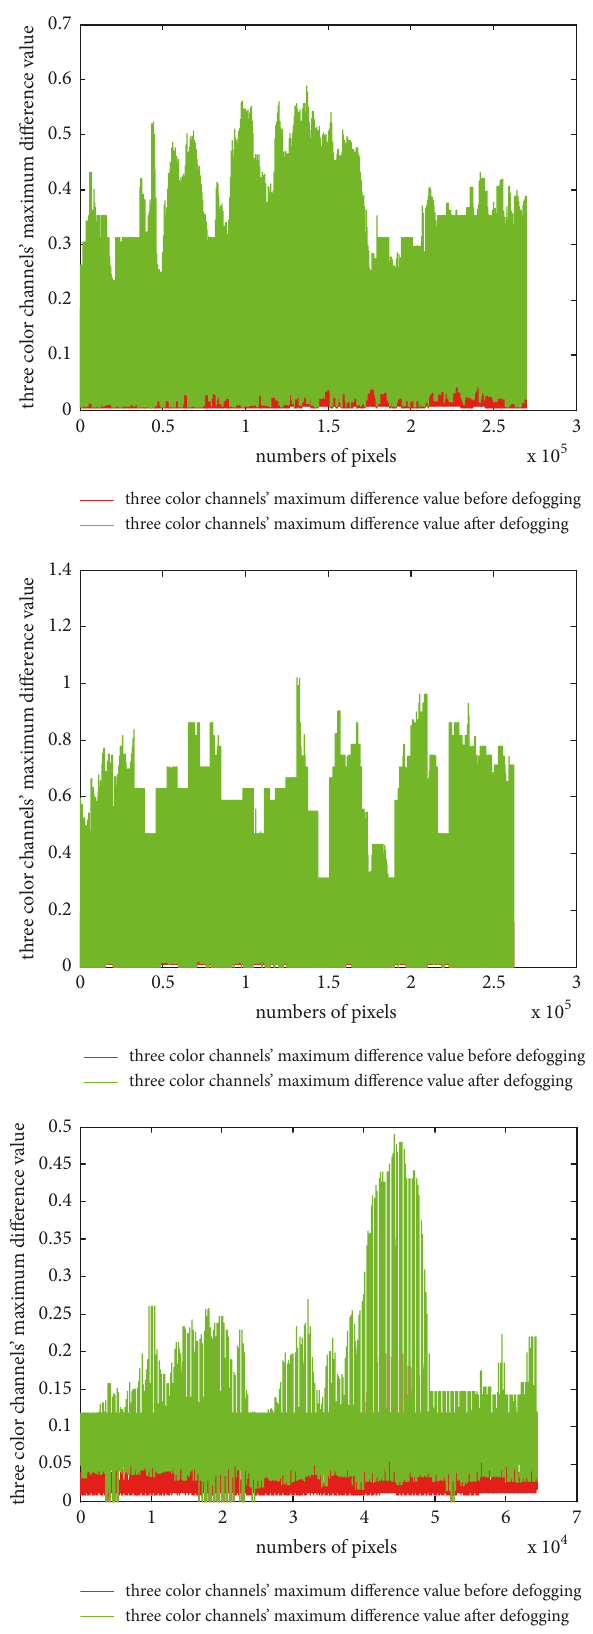
Figure 7: Numerical form of three color channels’ maximum difference